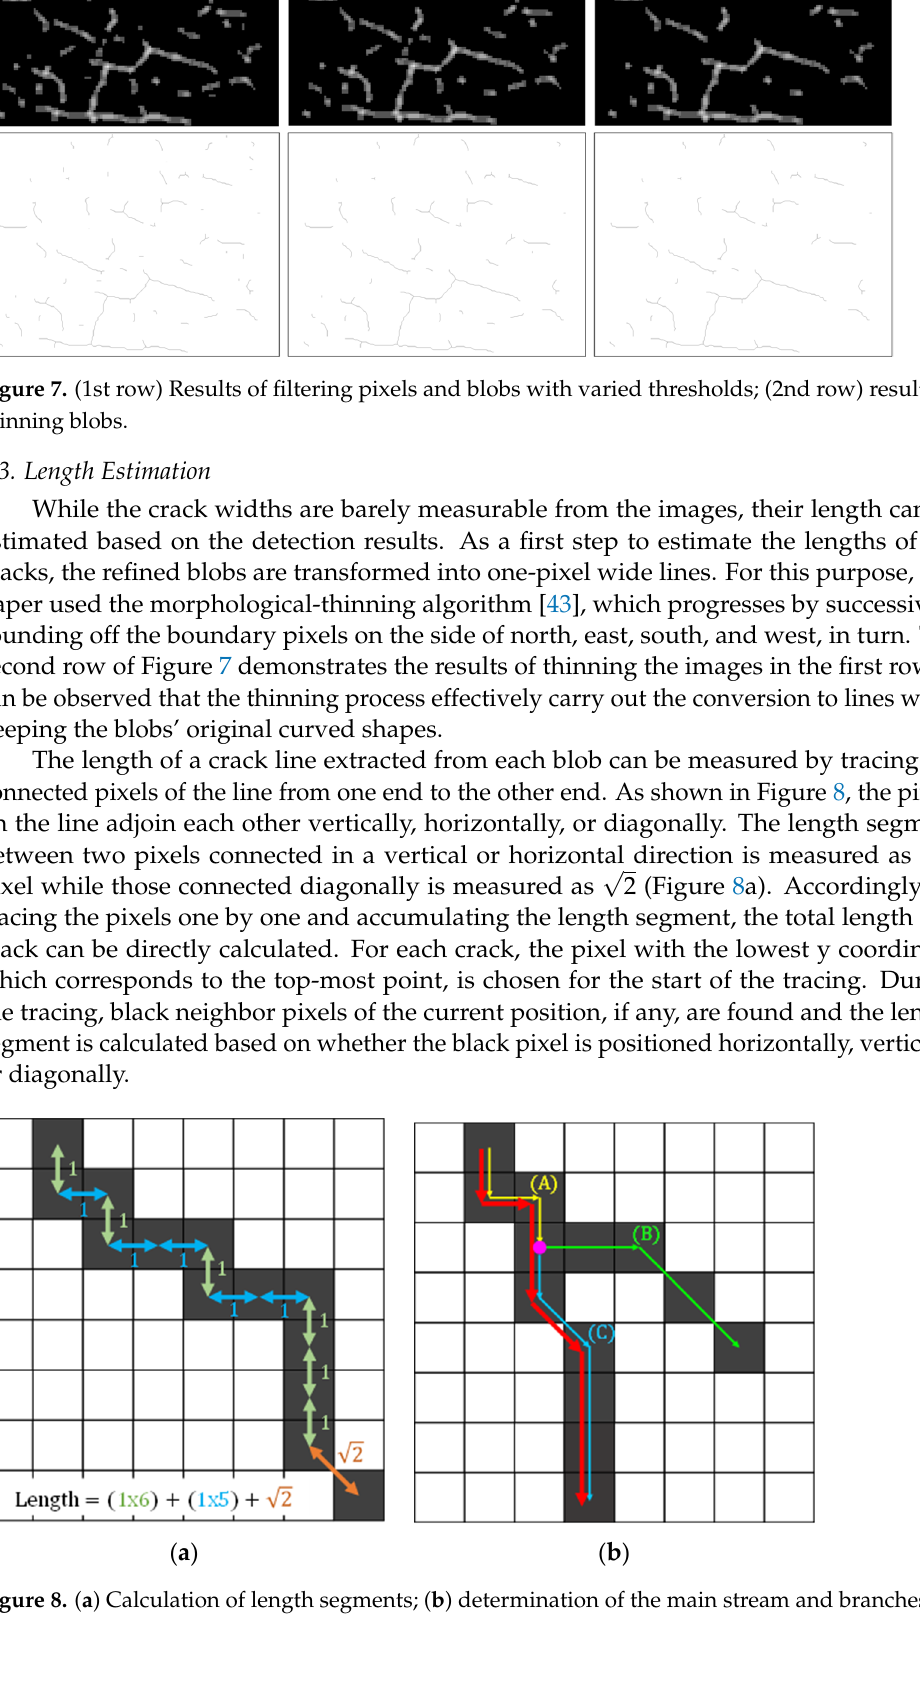
Figure 6. ( a ) Stride of a square region for cropping images; ( b ) crack detection result.